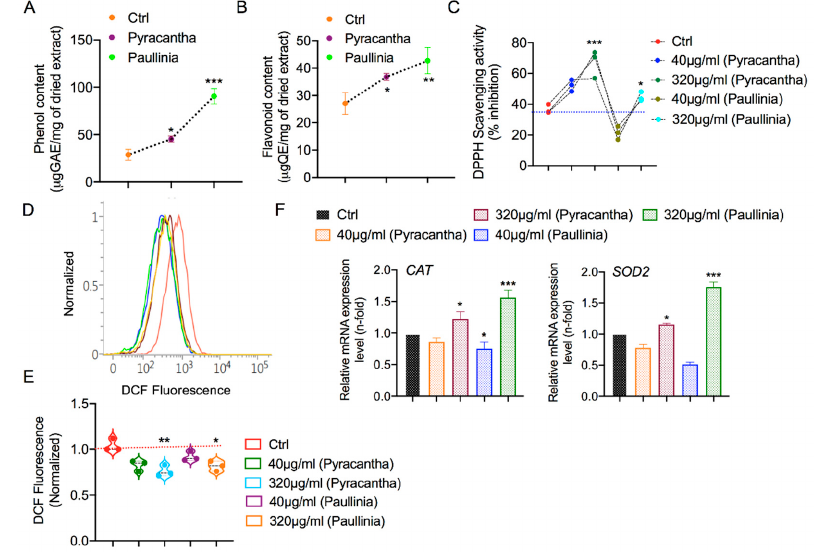
Figure 9. Determination of phytochemical components and antioxidant activity in Pyracantha and Paullinia extracts. Analysis of phenolic compounds ( A ), flavonoids ( B ), and antioxidant scavenging activity ( C ) in Pyracantha and Paullinia extracts. ( D and E ) Intracellular reactive oxygen species (ROS) levels in HEPG2 cancer cells following treatment with Pyracantha and Paullinia extracts at the indicated concentrations. ( F ) qPCR analysis of CAT and SOD2 ( MnSOD) antioxidant levels in HEPG2 cancer cells following treatment with Pyracantha and Paullinia extracts at the indicated concentrations. * p < 0.05; ** p < 0.01; *** p < 0.001.